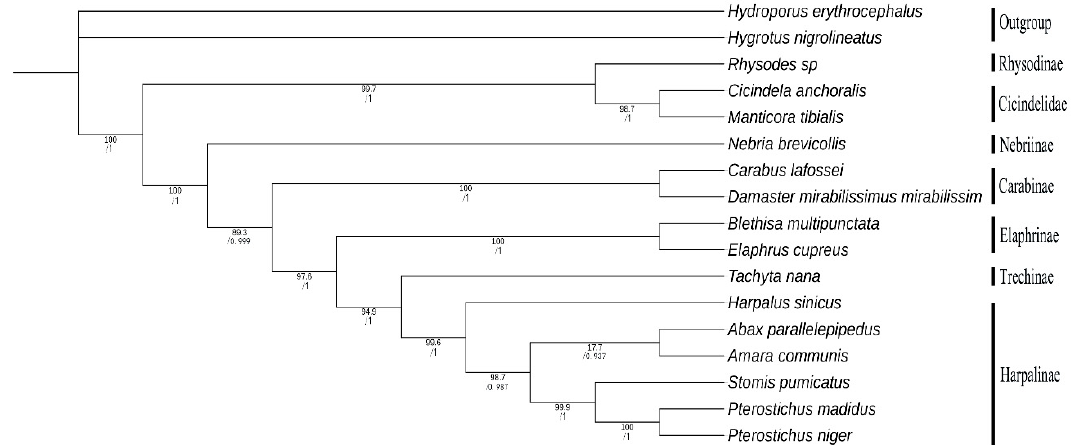
Figure 8. Phylogenetic trees of 15 Carabidae species based on 13 mitochondrial PCGs. Numbers refer to ML bootstrap proportions (above) and Bayesian posterior probabilities (below).